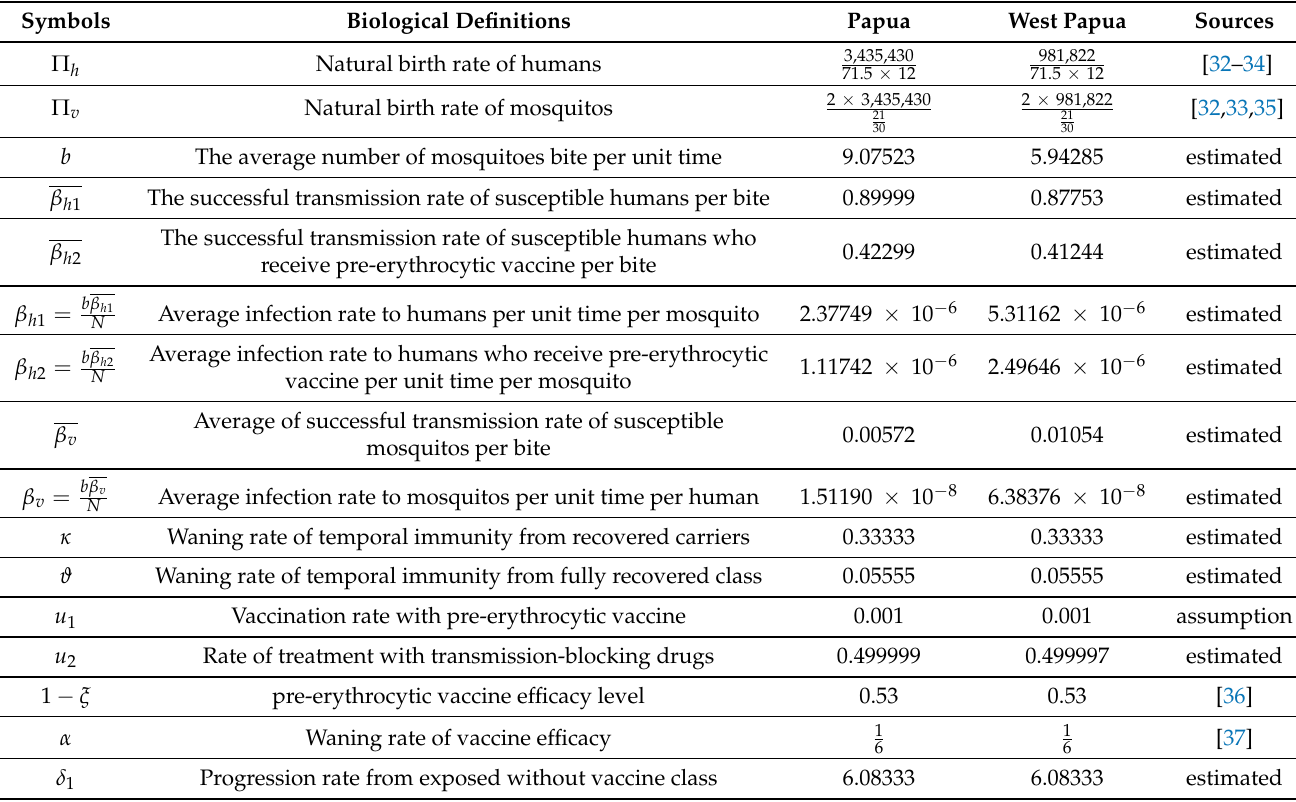
Table 1. The parameters of malaria model in (1). Some parameter values are taken from parameter estimation results in Section 2.2 and the rest are from